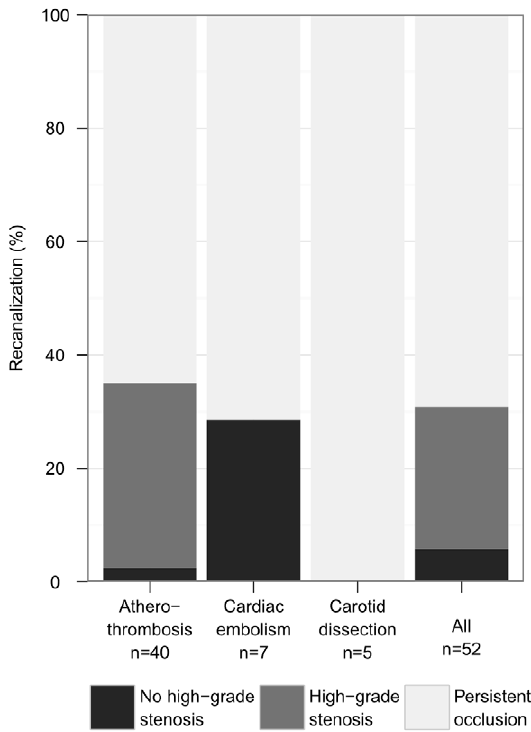
Figure 1. Recanalization rate for extracranial internal carotid artery occlusion after thrombolysis by aetiology. Aetiology was classified as carotid dissection, cardiac embolism, or atherothrombosis. The first control ultrasound exam was performed at a median 3.5 days after stroke.